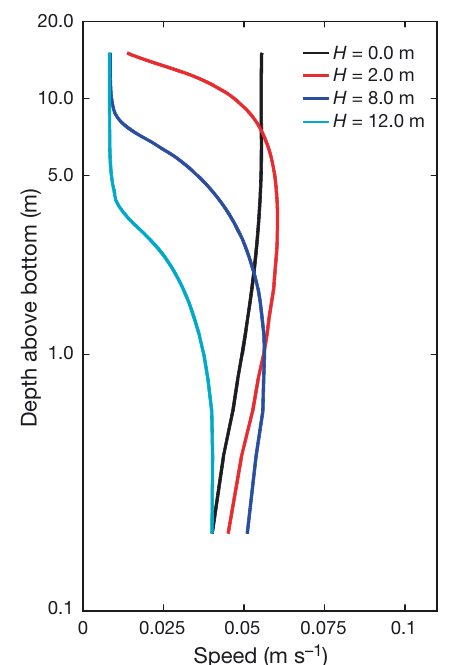
Fig. 10. Vertical distributions of tidal cycle averaged speeds with different cage heights (